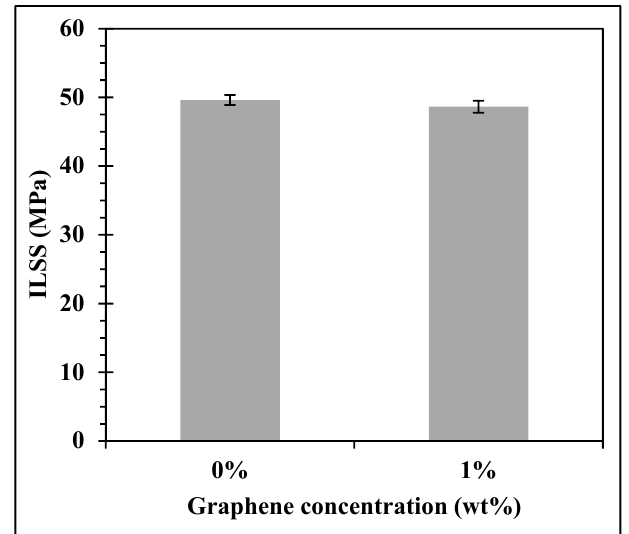
Figure 13. Interlaminar shear strength (ILSS).